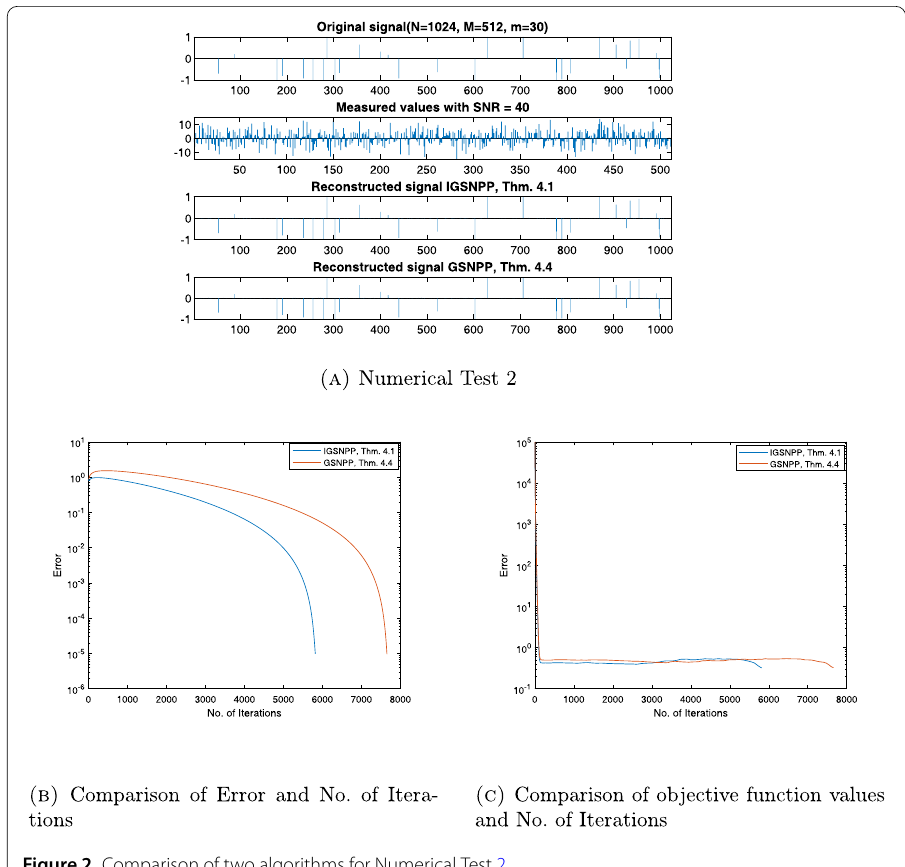
Figure 2 Comparison of two algorithms for Numerical Test